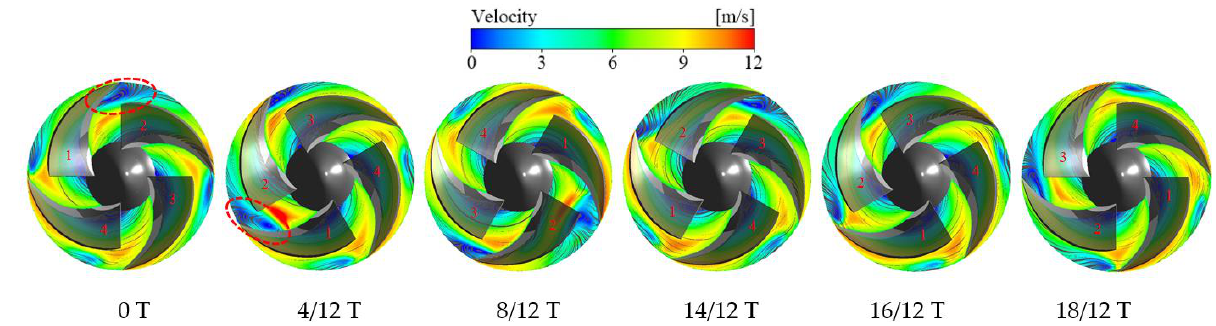
Figure 7. Velocity streamline diagram of impeller outlet section at different time ( δ = 0.2 mm).